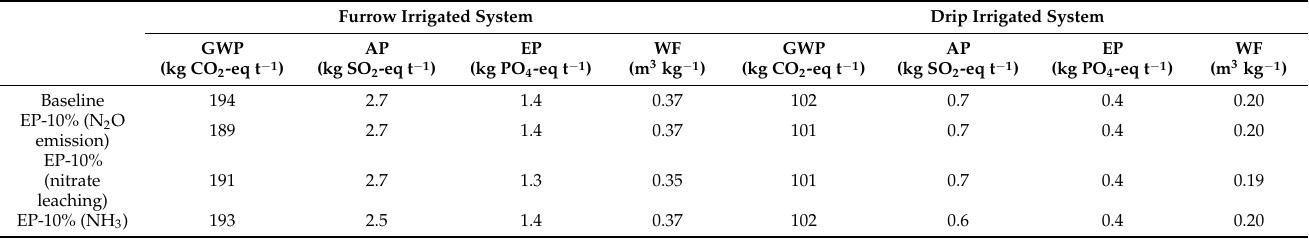
Table 3. Sensitivity analysis of changing the emission parameters of reactive nitrogen losses on the environmental impacts assessment. Furrow Irrigated